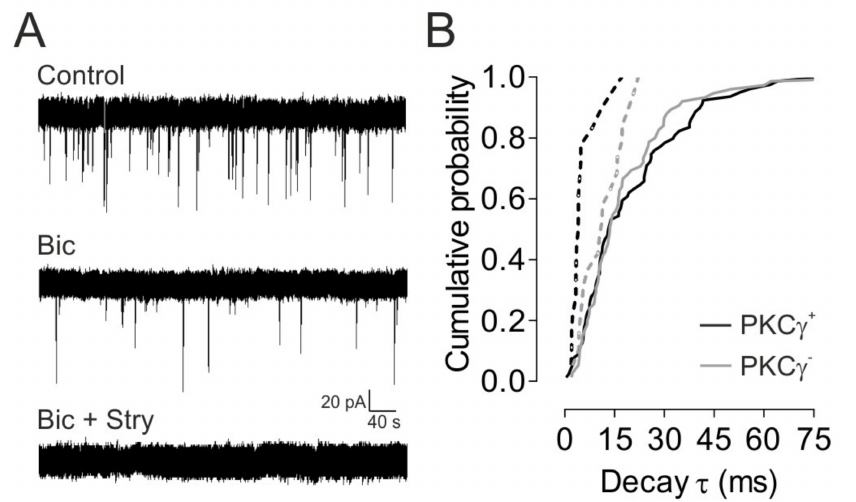
Figure 3. GlyR- and GABA A R-mediated sIPSCs in lamina II i PKC γ + and PKC γ − interneurons. ( A ) Whole-cell patch-clamp recordings (voltage-clamp mode; holding potential: − 65 mV) of spon- taneous inhibitory postsynaptic currents (sIPSCs) from a lamina II i PKC γ + interneuron in control condition (in the presence of CNQX (10 µ M) and APV (40 µ M)) and after application of bicuculline (Bic; GABA A R antagonist, 10 µ M) and strychnine (Stry; GlyR antagonist, 0.5 µ M). Note that sIPSC were strongly reduced (number) after bicuculline and completely abolished after bicuculline + strych- nine. ( B ) Cumulative probability plots of decay τ of sIPSCs recorded from 4 lamina II i neurons, 2 PKC γ + (black), and 2 PKC γ − (gray) neurons. The plots were constructed by forcing monoexpo- nential fits to all individual sIPSCs recorded under control conditions (solid lines) and then in the presence of bicuculline (dashed lines). Note that bicuculline abolished all events with decay τ higher than 20